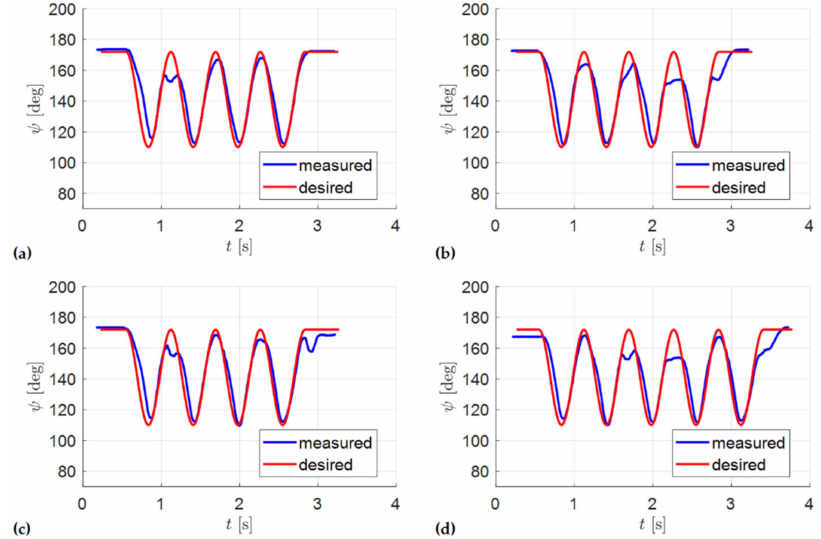
Figure 29. Results in the form of knee angle measured and desired (from the planned trajectory) for four sets of experiments: ( a ) Experiment A; ( b ) Experiment B; ( c ) Experiment C; ( d ) Experiment